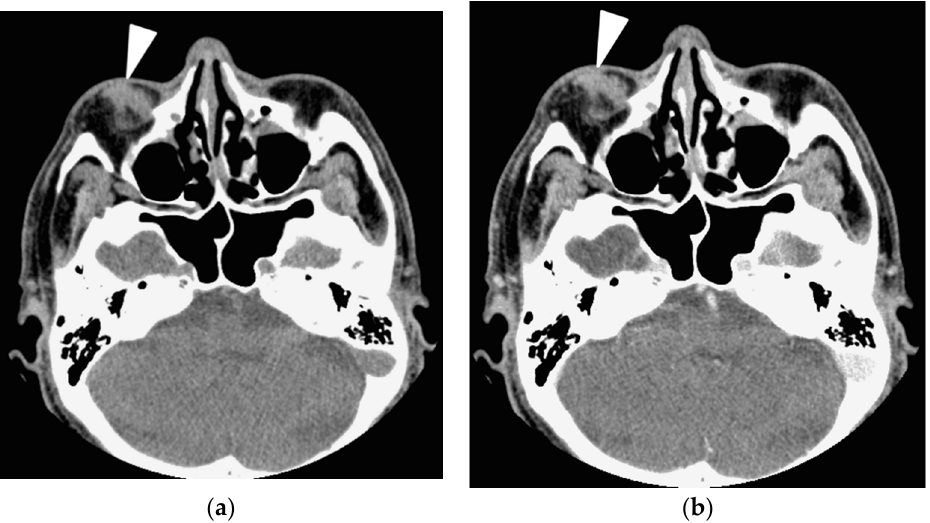
Figure 2. A 66-year-old man with orbital lymphoma shows a painless solitary lesion at the right lower eyelid. ( a ) Axial precontrast CT image shows a small nodule with an irregular border and homogeneous density involves the preseptal space of the right lower eyelid (arrowhead). Precontrast CT Hounsfield unit scale (CTHU) of the nodule is 57; ( b ) Axial postcontrast CT image shows the nodule demonstrates homogeneous enhancement (arrowhead). Postcontrast CTHU of the nodule is 68. Serum IgG4 level of the patient is 44.3 mg/dL.